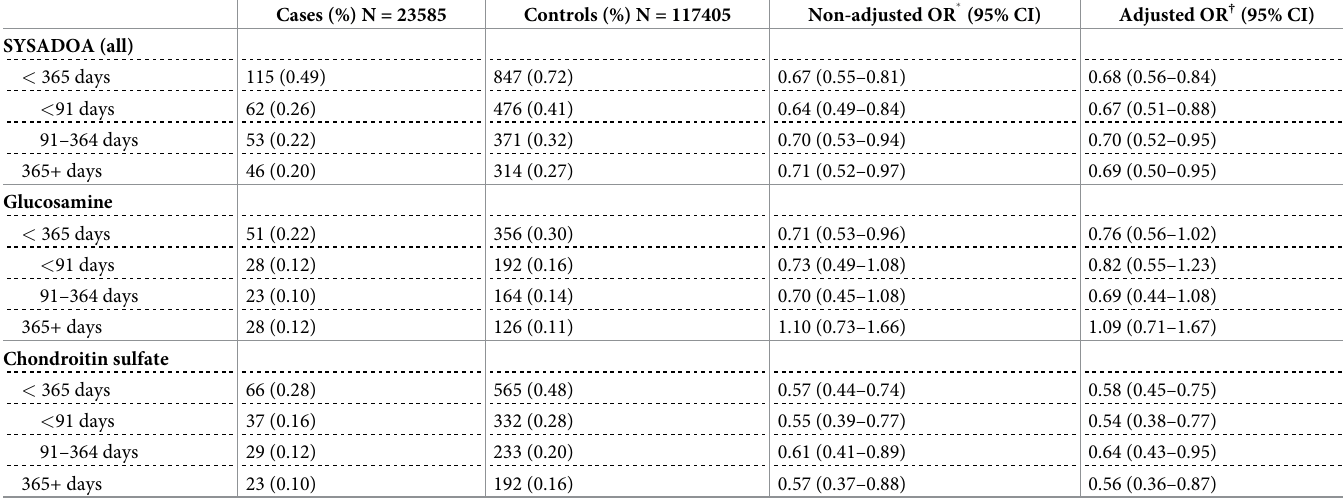
Table 3. Risk of AMI associated with the current use of chondroitin sulfate and glucosamine as compared to non-use according to duration of treatment. Cases (%) N =